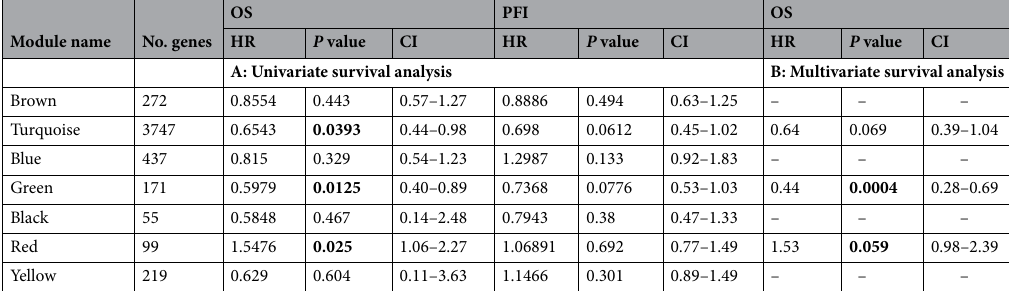
Green module Red module